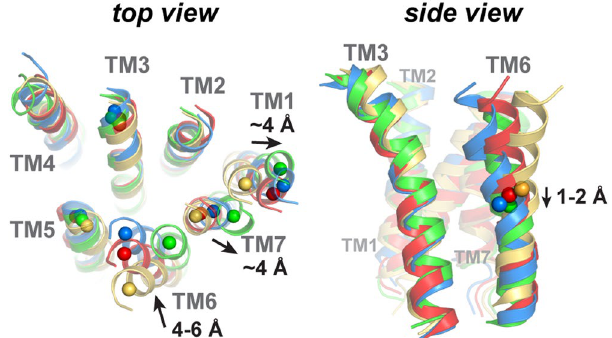
Figure 2. Top and side views of the final models to illustrate the helical rearrangements during the open-to- closed transition. Left: the center-of-mass (COM) of the first four residues in a helical turn of the TM helix. Right: the COMs of TM6 are represented as spheres to guide the